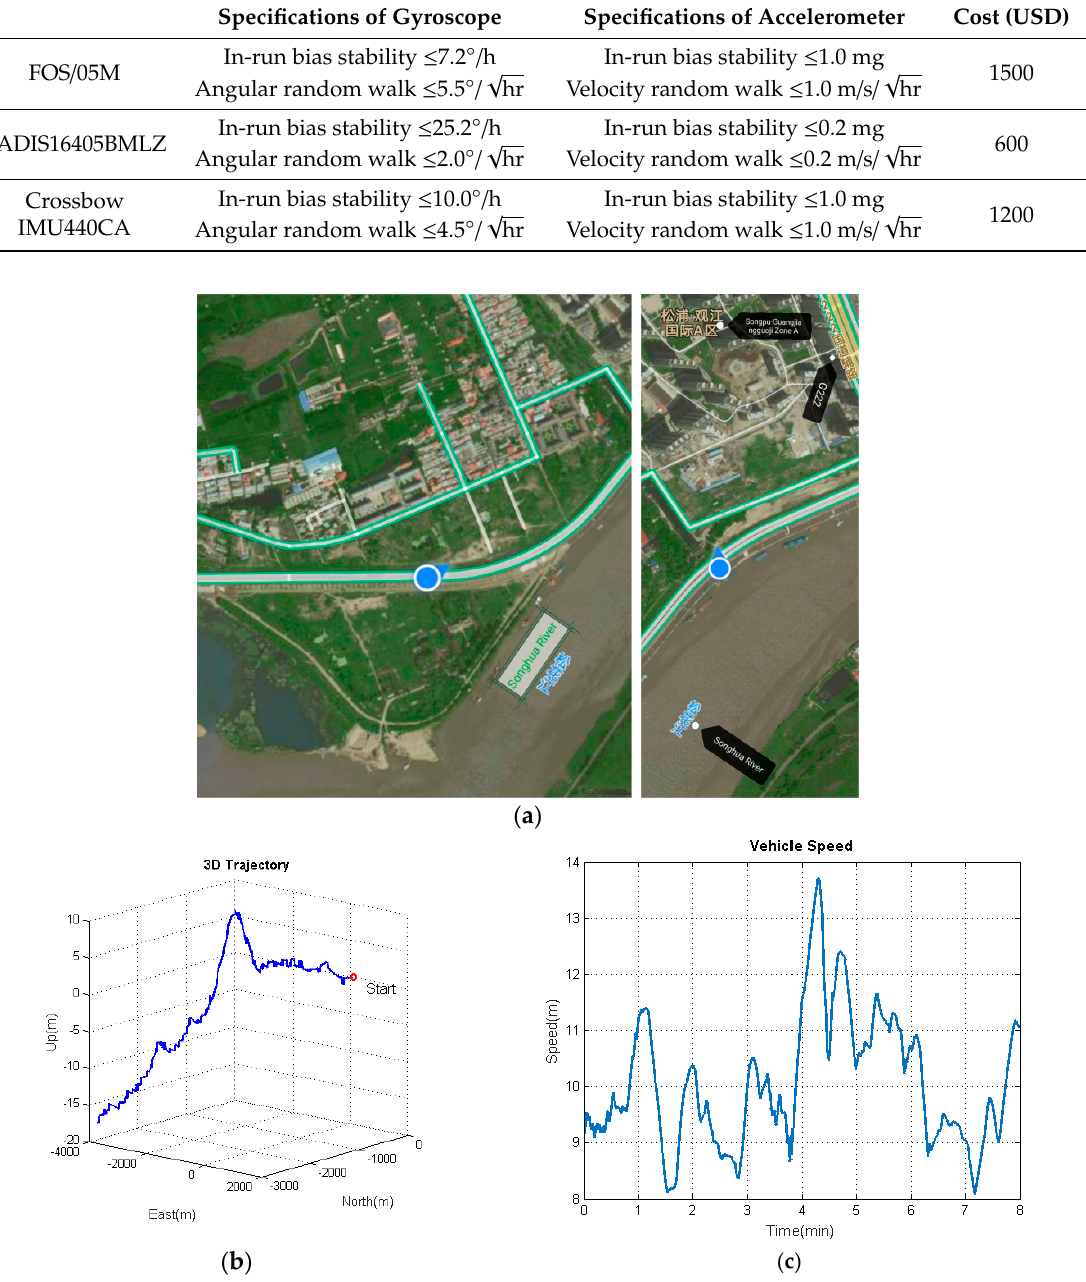
Figure 5. The trajectory and velocity of the test vehicle. ( a ) Trajectory capture map; ( b ) three-dimensional (3D) trajectory; ( c ) velocity profile.